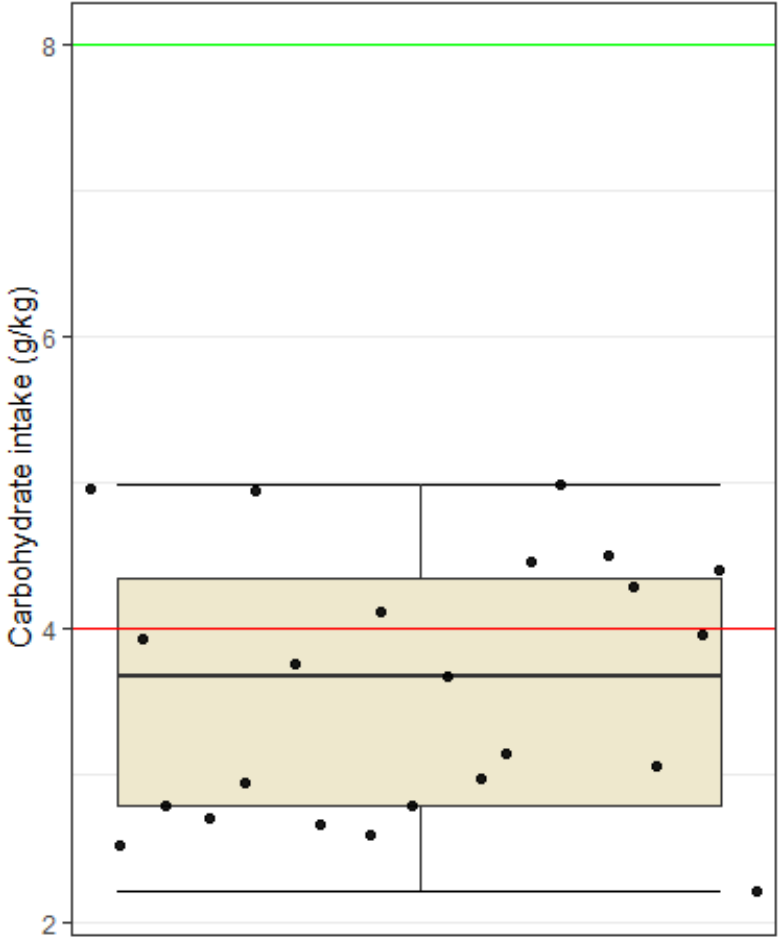
Figure 2. Carbohydrate intake among football players. Dots represent individual participants ( n = 23). The red line indicates the lower limit of the recommended intake for football players in the preseason period (4 g/kg BW), and the green line indicates the upper limit of the recommendation (8 g/kg BW). Dietary intake of protein and fat was adequate among subjects. On average, they consumed 1.8 g of protein/kg BW, which is in line with the recommendations (1.6–2.2 g protein/kg BW). However, 35% of football players did not reach the lower limit of 1.6 g of protein/kg body weight (Figure 3). The range of protein consumption among football players was between 0.9 to 3.5 g/kg BW. A one-tailed t -test showed that the sample mean protein intake is not statistically significantly higher than 2.2 g/kg BW ( t = − 3.46, df = 22, p = 0.99).